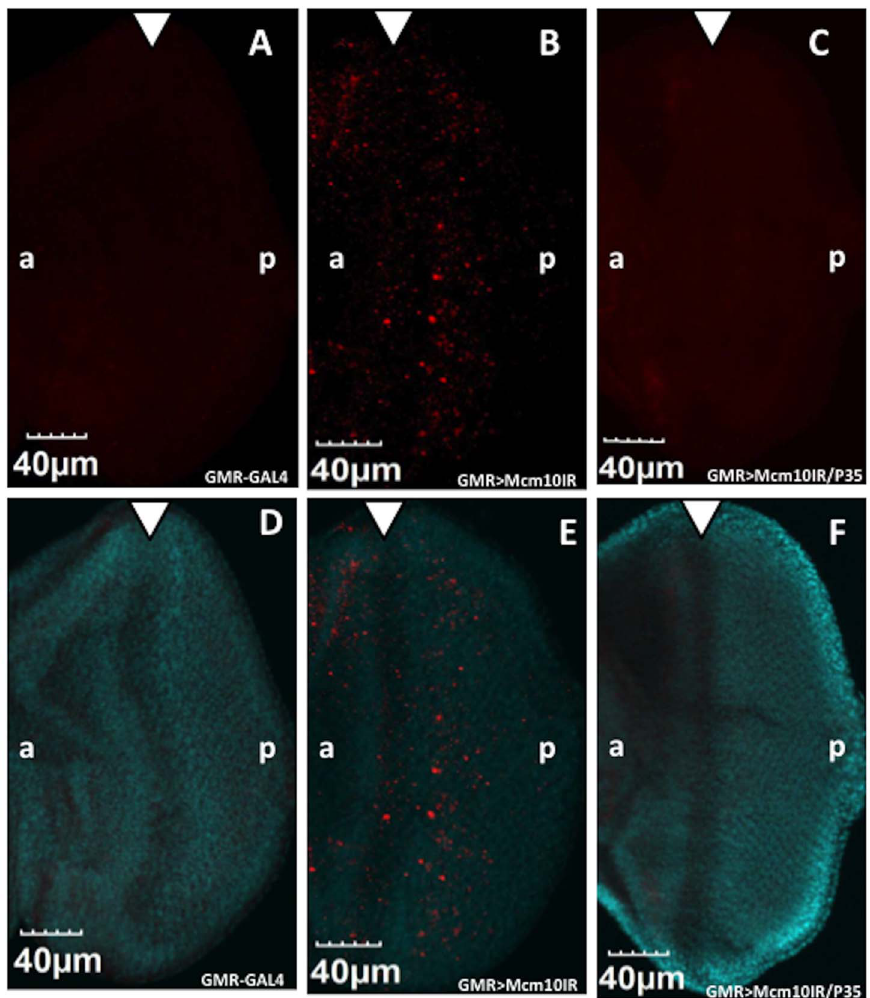
Figure 7. Knockdown of dMcm10 in eye imaginal discs induces apoptosis. The eye imaginal discs of third instar lavae were stained with anti- cleaved caspase-3 antibody(A, B, C) (Red). The merged images of eye discs stained with DAPI for DNA (Blue) and anti-cleaved caspase-3 antibody (Red) (D, E, F). (A, D) GMR -GAL4/ yw ; + ; + ; (B, E) GMR -GAL4/ yw ; + ; UAS- Mcm10IR 633-700 / + ; (C, F) GMR -GAL4/ yw ; + ; UAS- Mcm10IR 633-700 /UAS- P35 . White arrowhead shows morphogenetic furrow. The flies were reared at 28 u C. Bars indicate 40 m